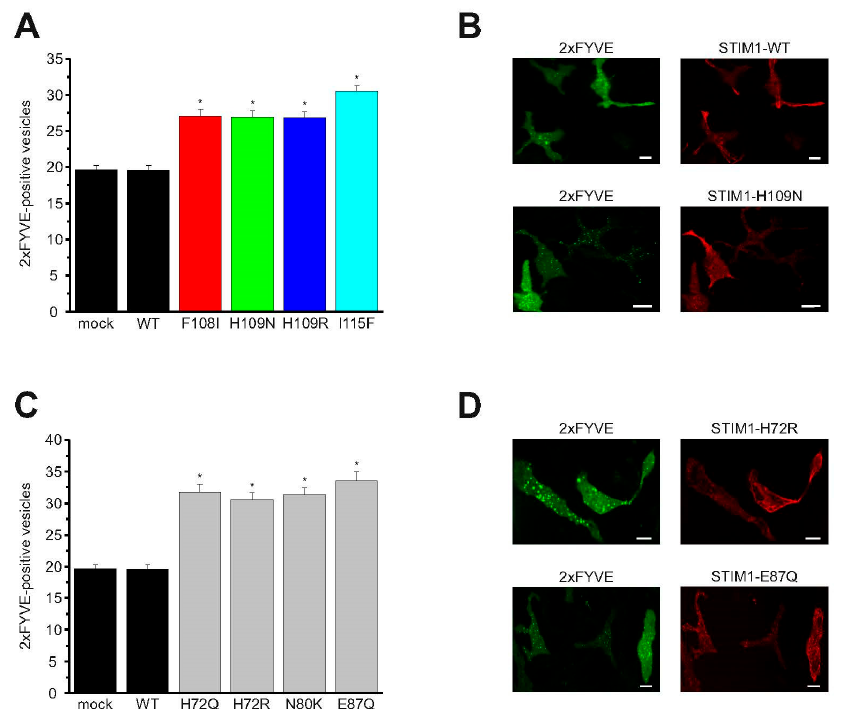
Figure 5. Activation of autophagic pathways by STIM1 canonical and non-canonical EF-hand mutants. ( A ) Average number of 2xFYVE positive vesicles per cell with overexpression of no STIM1 (mock), STIM1 wild type, STIM1-F108I, STIM1-H109N, STIM1-H109R, and STIM1-I115F, respectively. Each mutant was measured on three different days with n = 66 to 110 cells. An asterisk (*) indicates a significantly increased number of 2xFYVE positive vesicles found in cells overexpressing STIM1 mutants compared to cells overexpressing STIM1 wild type ( t -test: p < 0.01). ( B ) Representative images of cells co-overexpressing lysosomal marker 2xFYVE as well as STIM1 wild type and STIM1-H109N, respectively. Scale bar 10 µ m. ( C ) Average number of 2xFYVE positive vesicles per cell with overexpression of no STIM1 (mock), STIM1 wild type, STIM1-H72Q, STIM1-H72R, STIM1-N80K, and STIM1-E87Q, respectively. Each mutant was measured on three different days with n = 45 to 110 cells. An asterisk (*) indicates a significantly increased number of 2xFYVE positive vesicles found in cells overexpressing STIM1 mutants compared to cells overexpressing STIM1 wild type ( t -test: p < 0.01). ( D ) Images representing cells co-overexpressing lysosomal marker 2xFYVE as well as STIM1-H72R and STIM-E87Q, respectively. Scale bar 10 µ